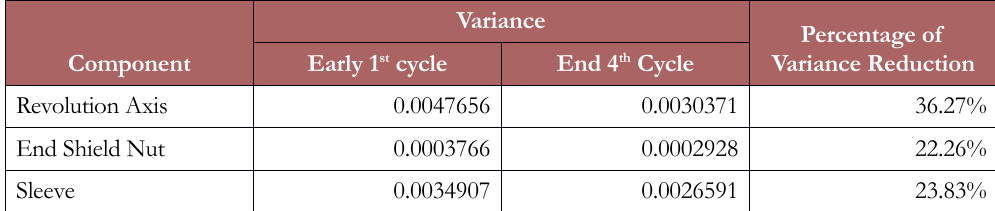
Table 12. Variance Reduction in manufacturer